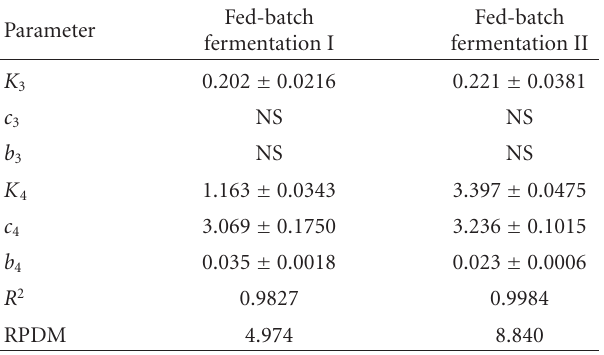
Table 3: Parameter values (means ± SD) of the bi-Logistic equation (A.3) used for predicting the biphasic growth data of Ent. faecium CECT 410 in the two realkalized fed-batch fermentations in whey.